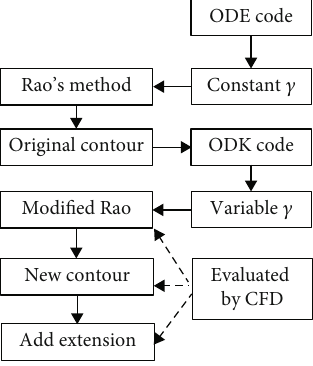
Figure 1: Design